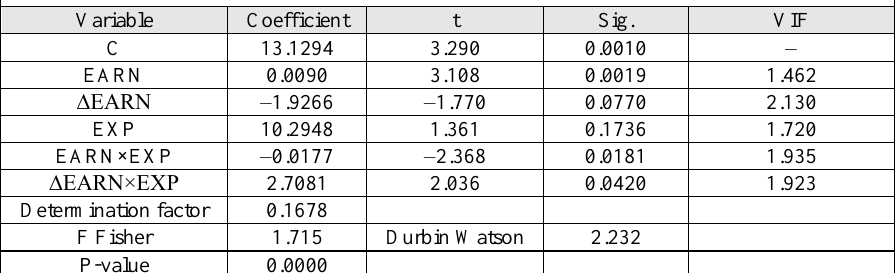
Table 6: Results of statistical analysis for hypothesis